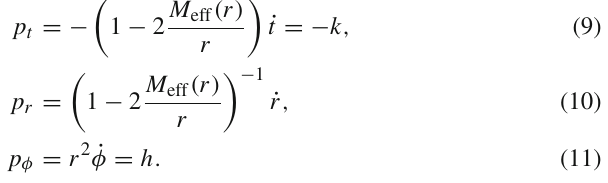
Fig. 1 Plots of the improved metric coefficient f ( r ) for M = 0 . 4 < M c (blue), M = M c (red), and M = 1 . 4 > M c (green), with M c = 1 corresponding to ξ = 16 / 27. The dashed line shows the classical f 0 ( r ) for M = 1 .